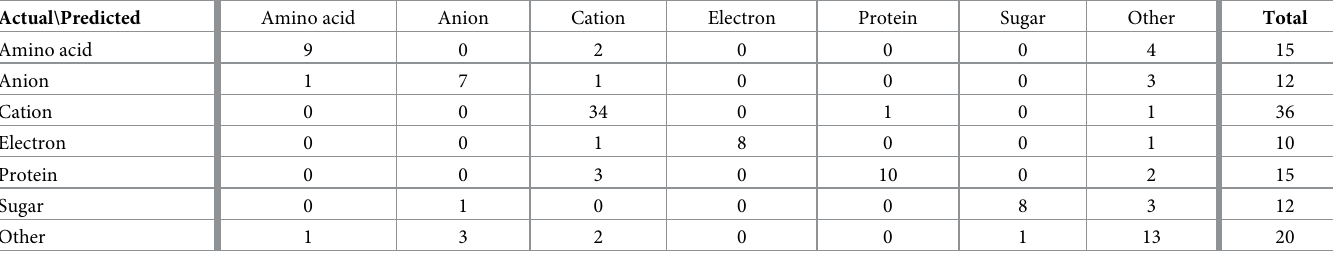
dealing with imbalanced data.